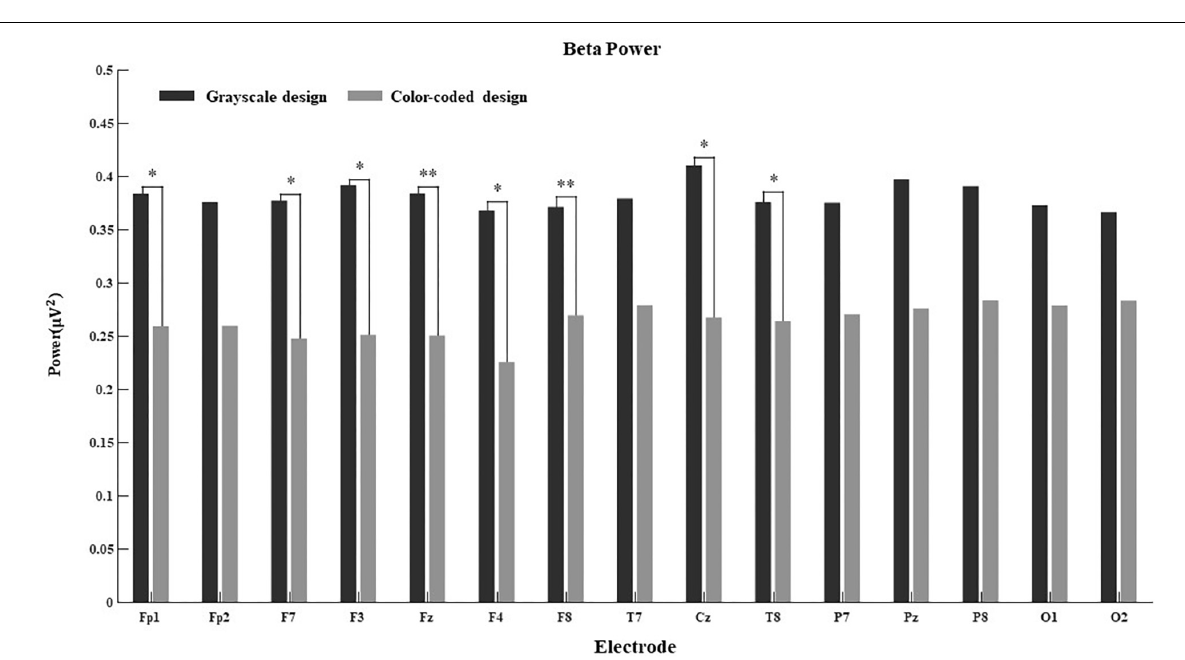
evidence that color coding helps to form an association between verbal and program code representations because the items processed timely are related to each other (Raaijmakers and Shiffrin, 1981; Kahana, 1996). Color